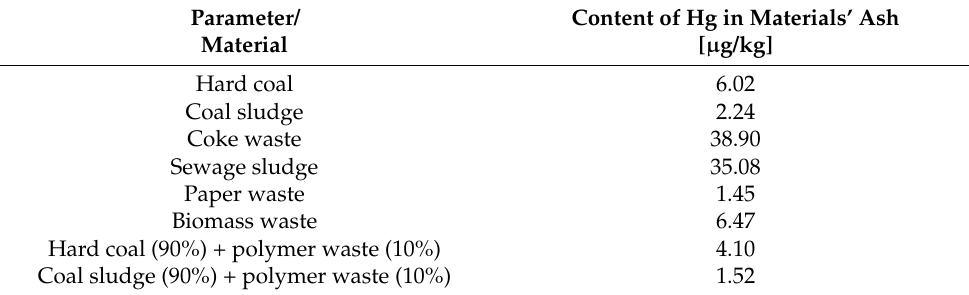
Table 4. Analysis of material samples during the combustion process.